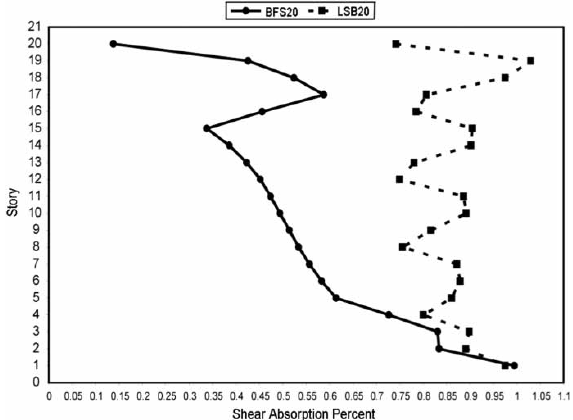
Fig. 20. Shear absorption percent of brace system in BFS20 and LSB20 models